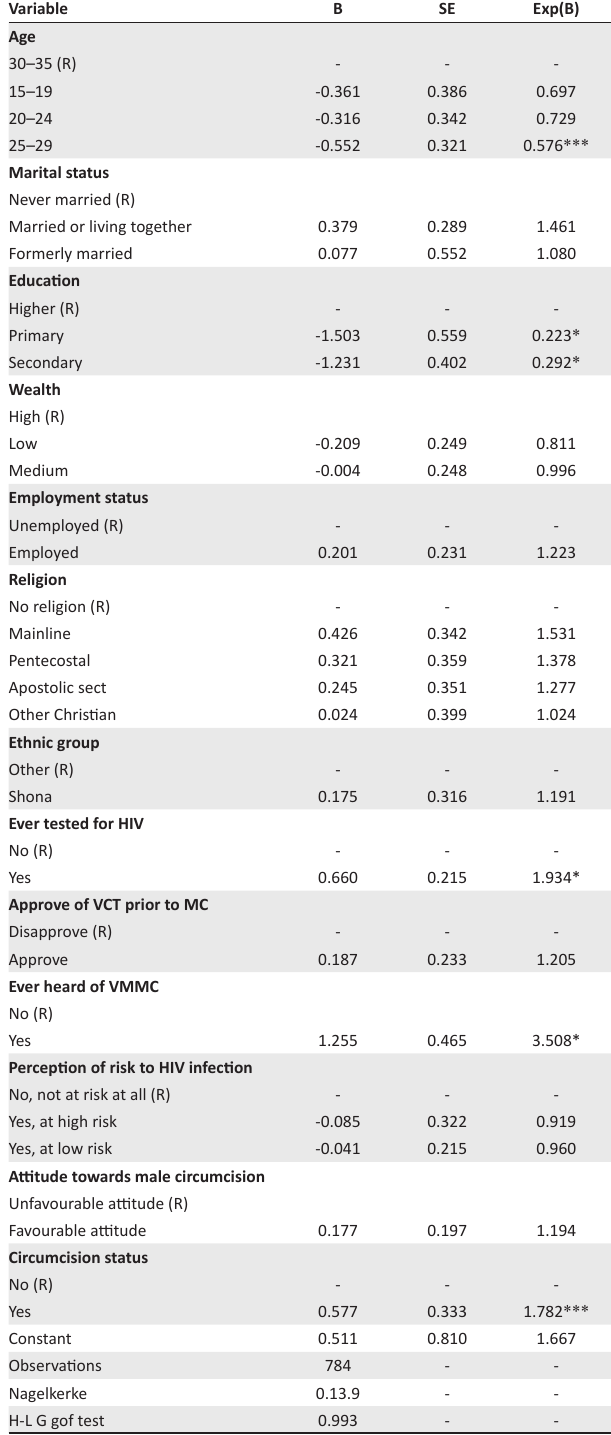
TABLE 3: Background characteristics by knowledge about male circumcision. Variable